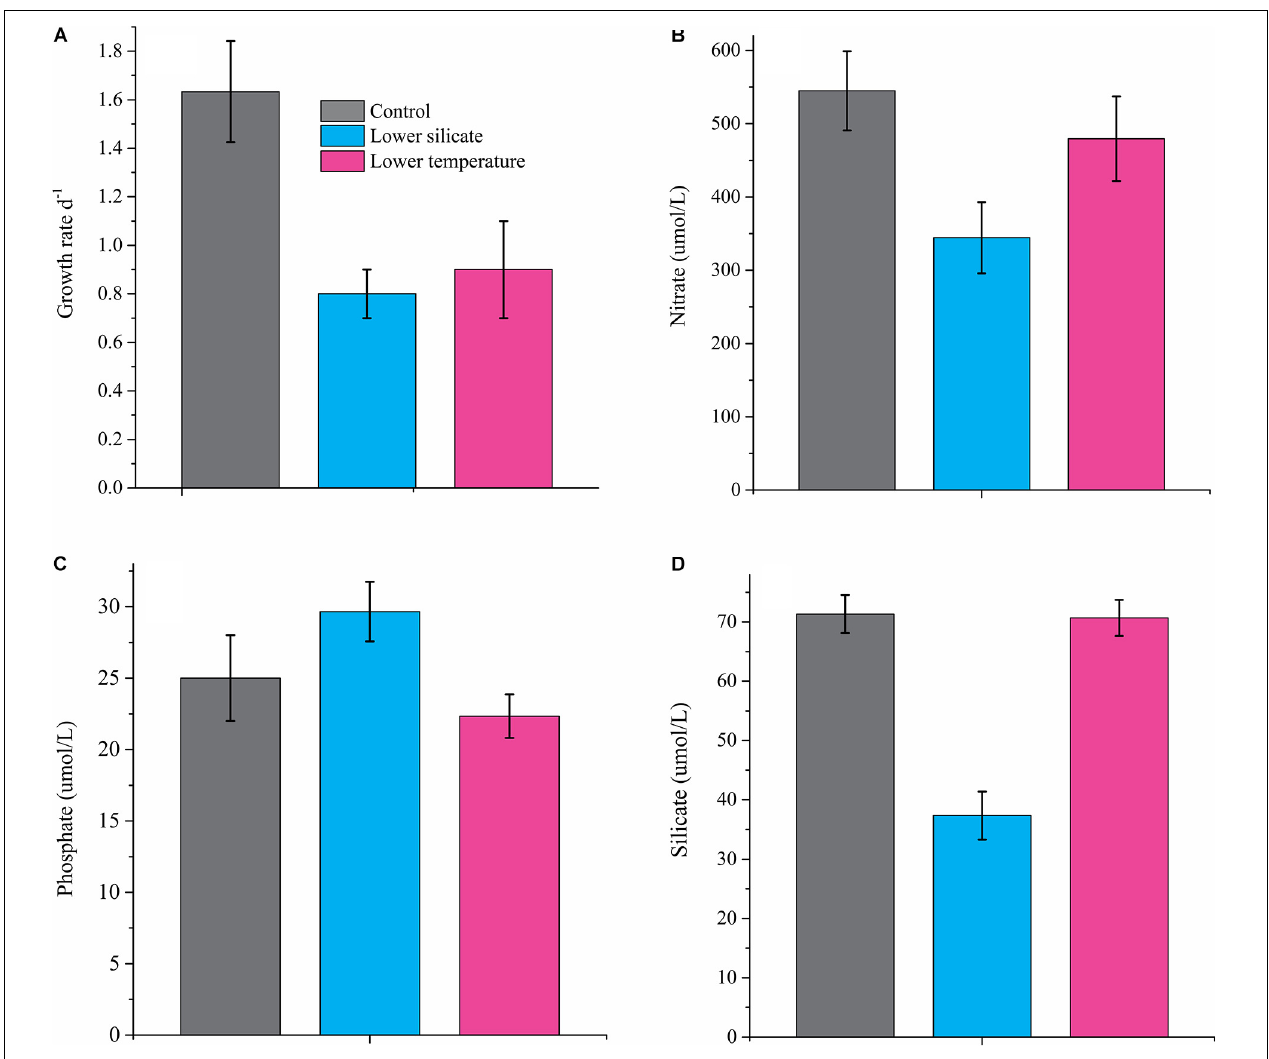
FIGURE 1 | The specific growth rate of S. dohrnii grown under normal conditions, silicate and temperature limitation (A) , and external nutrient concentration, nitrate (B) , phosphate (C) , and silicate (D) in culture media. Error bars represent the standard deviation of the means ( n =